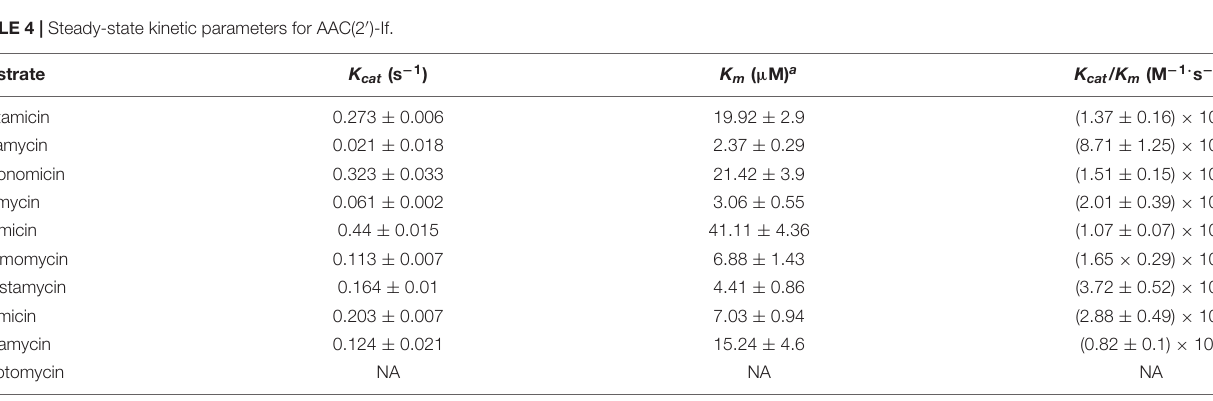
TABLE 4 | Steady-state kinetic parameters for AAC(2 (cid:48)